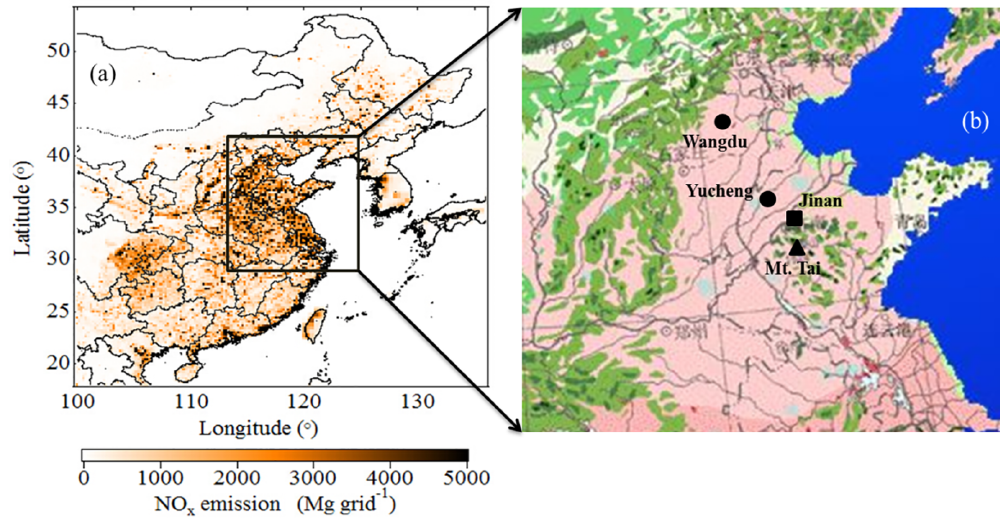
Figure 1. Maps of the study region show (a) the NO x emission intensity and (b) the four sampling sites. Table 1. Sampling sites and sampling periods involved in this